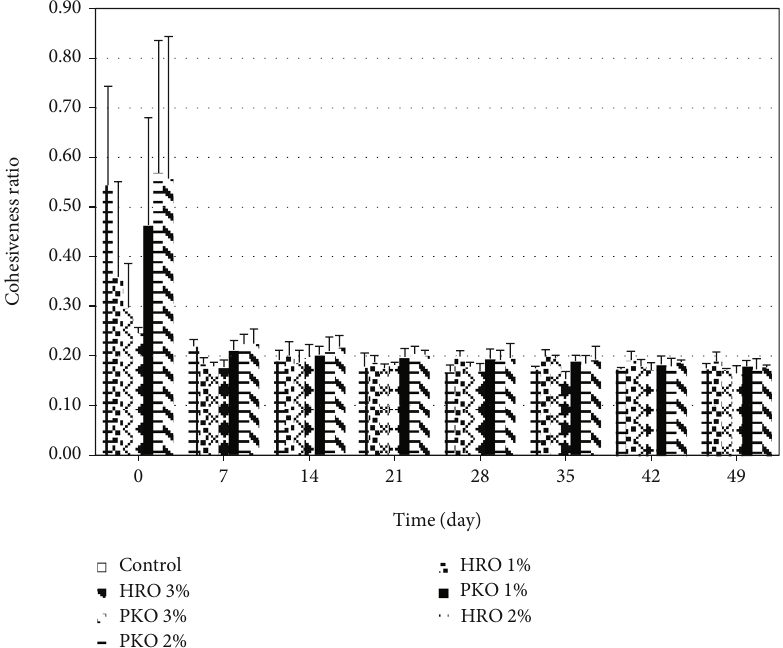
Figure 5: The e ffi cacies of HRO and PKO on the cohesiveness of the seed butter.